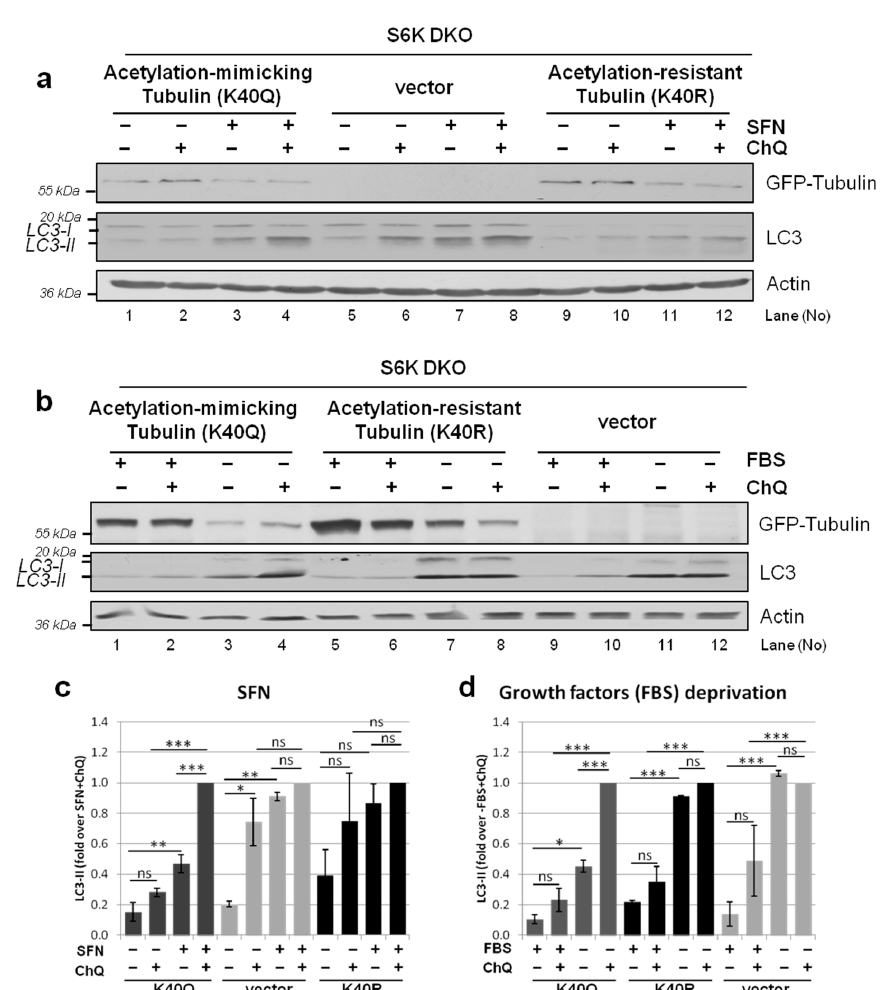
Figure 10. Overexpression of an acetylation-mimicking but not acetylation-resistant variant of tubulin restores autophagic flux in stressed S6K DKO MEF. The impact of the overexpression of acetylation-mimicking (K40Q) or acetylation-resistant (K40R) GFP-tubulin variants on autophagic flux during stress induced by SFN (20 µ M; 3 h) ( a,c ) or growth factor deprivation ( − FBS; 24 h) ( b,d ) in S6K DKO MEF was evaluated by immunoblotting. Cells transfected with an empty vector served as a control. To assess the autophagic flux, chloroquine (ChQ; 10 µ M), a lysosomal inhibitor, was added for the last 2 h of treatment, as indicated. GFP-tubulin and LC3 protein levels were evaluated by western blotting. The blots were re-probed with anti- β -actin antibodies to ensure equal protein loading. Densitometric data, corrected for loading control, are shown as a fold-change from the reference, i.e., the cells transfected with the control, acetylation-mimicking (K40Q) or acetylation-resistant (K40R) GFP-tubulin vector, and treated with SFN + ChQ (lane 8 , 4 and 12 , respectively) ( a,c ) or deprived of FBS + ChQ ( lane 12 , 4 and 8 , respectively) ( b,d ). The experiments were performed in three independent replicates. The data are shown as the mean ± SEM. The statistical significance of differences was determined by one-way ANOVA followed by Bonferroni’s multiple comparison test: * p < 0.05; ** p < 0.01, *** p < 0.001; ns, not